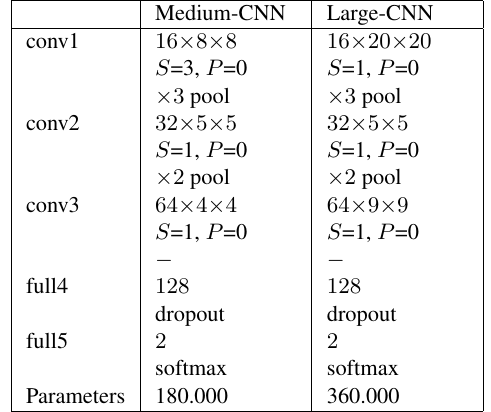
Table 1. Architecture of CNNs designed and trained from the scratch.